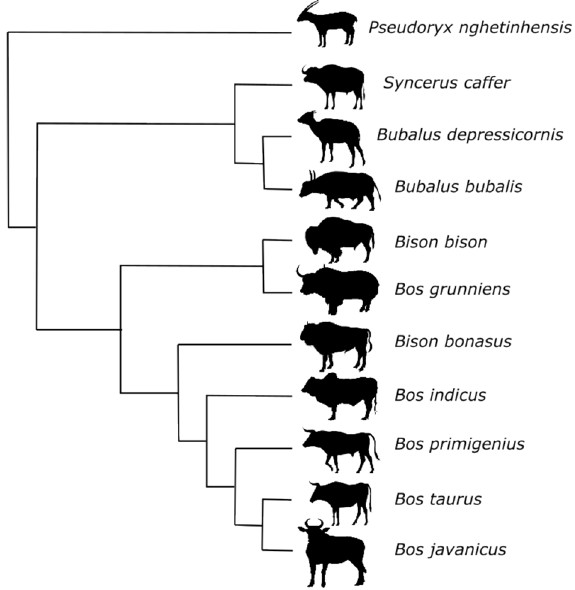
Figure 2. Molecular phylogeny of bovids. The phylogenetic relationships of 11 species of bovids were addressed using their protein-coded mitogenomes and different tree building methods (including classical alignment- based methods). Most methods produced the same tree topology shown in this